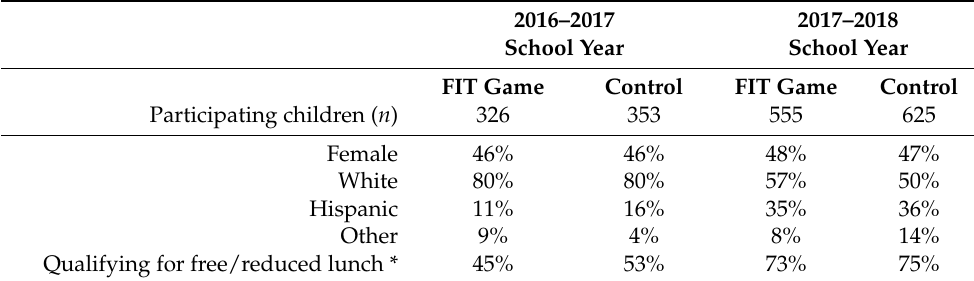
Table 1. Number of participants and demographics of all children attending the four participat- ing